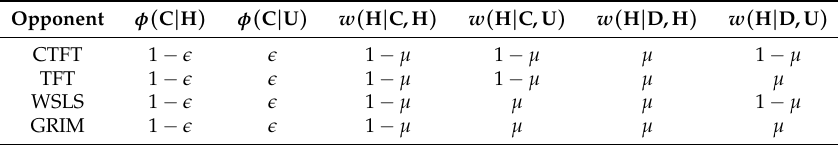
Figure 1. Probabilistic Finite-State Machines (PFSMs). Open circles represent the opponent’s states (i.e., Happy (H) or Unhappy (U) inside the circles); arrows represent the most likely state transitions, which occur with probability 1 − µ , depending on the opponent’s present state (i.e., the roots of the arrows) and the agent’s action (i.e., C or D aside the arrows). Table 1. Parameters of the PFSMs. Note that φ ( D | s ) = 1 − φ ( C | s ) and w ( U | a , s ) = 1 − w ( H | a , s ) for any s ∈ S and a ∈ A . CTFT, Contrite Tit for Tat; WSLS, Win Stay Lose Shift; GRIM, Grim Trigger.